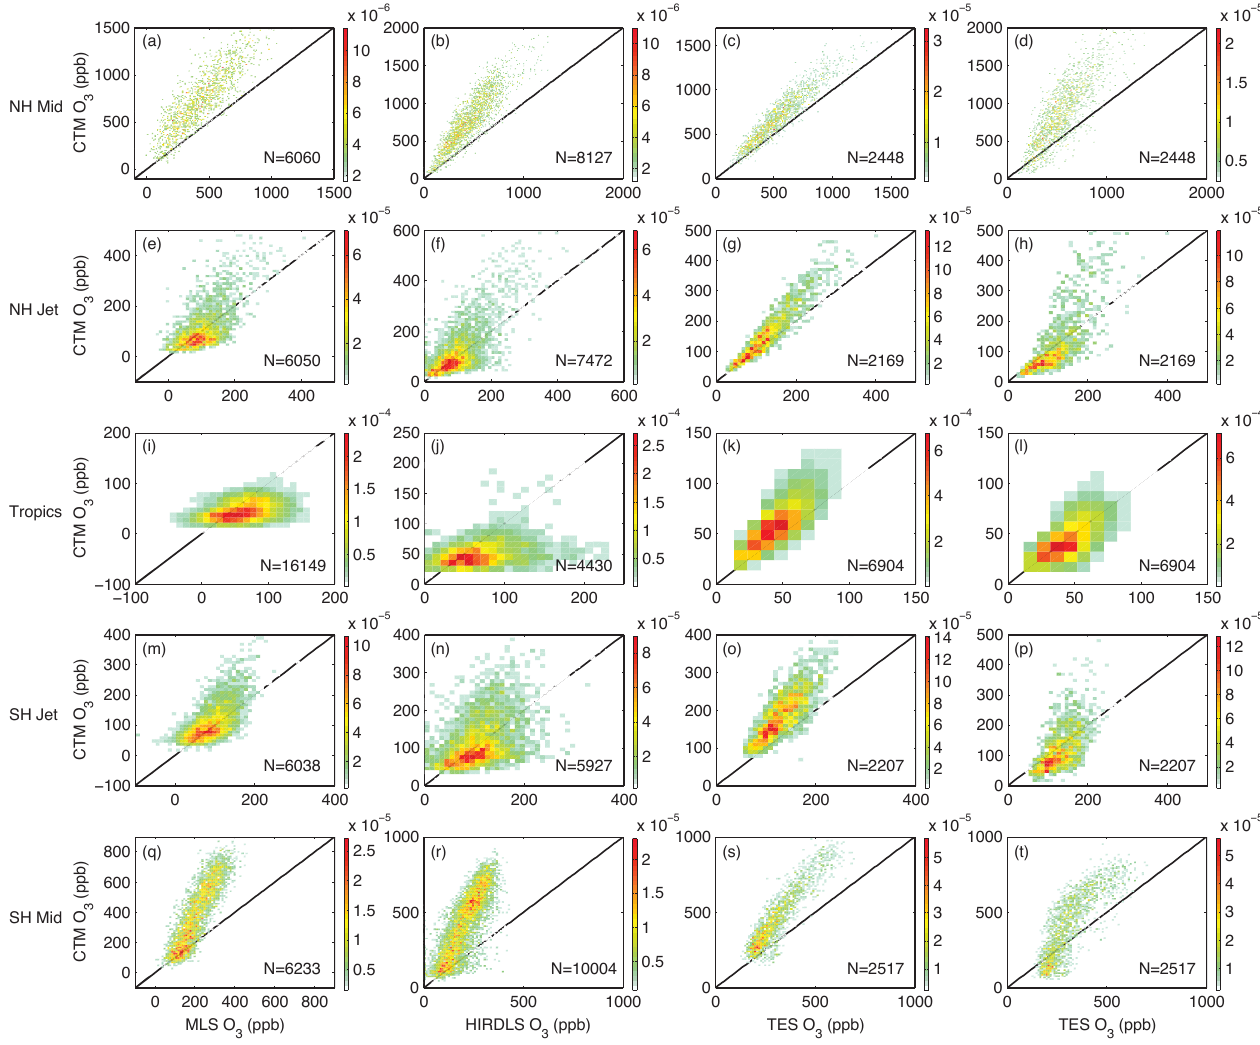
Fig. 8. Same as Fig. 5 for January 2006 at 147hPa. The mean biases and RMS are given in Table